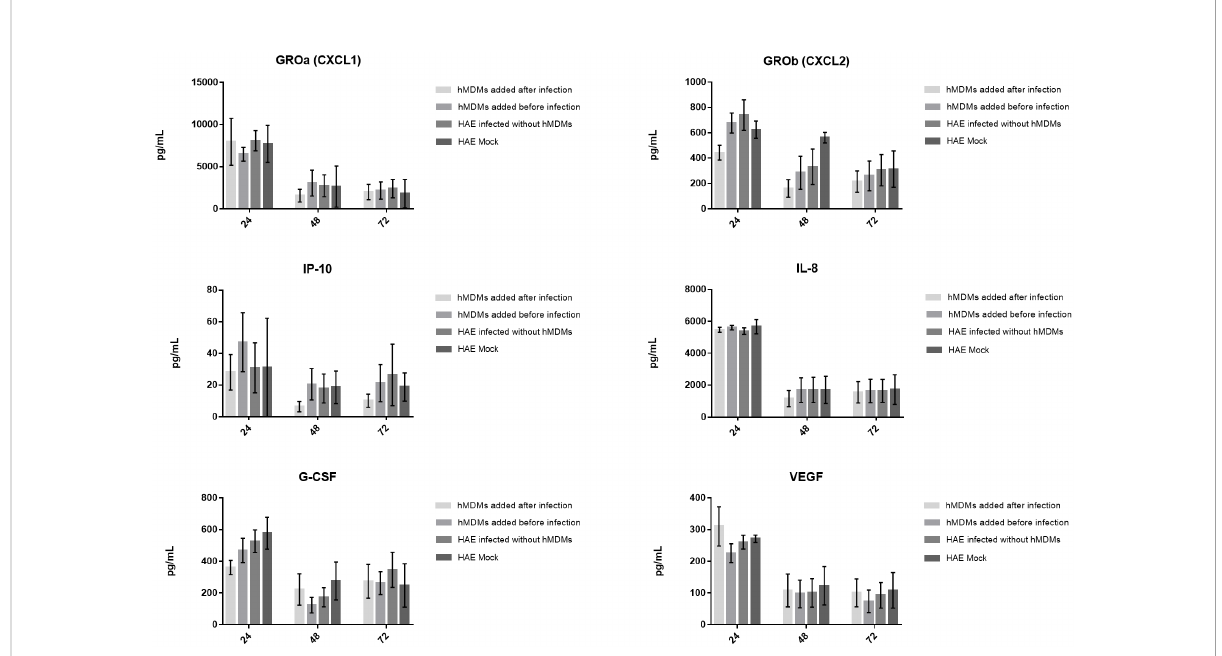
FIGURE 5 Production of cytokines and chemokines by the SARS-CoV-2 infected co-cultures. The graphs show the cytokine content in pg/ml present in the culture medium. Data was obtained from three independent experiments; each experiment was performed in triplicate and means ± SEM are shown. Groups were compared using Kruskal-Wallis test and Dunn ’ s multiple comparisons